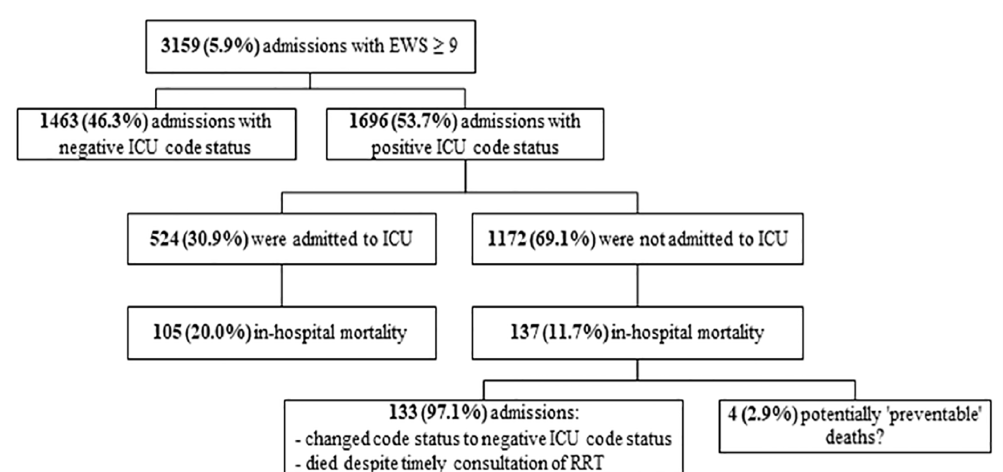
Figure 5. Flowchart of patients with high-risk Early Warning Score (EWS). The “preventable” adverse events group was characterized by patients with a high-risk EWS and a positive ICU code status (to be admitted to the ICU), who were not admitted to the ICU and died during hospital